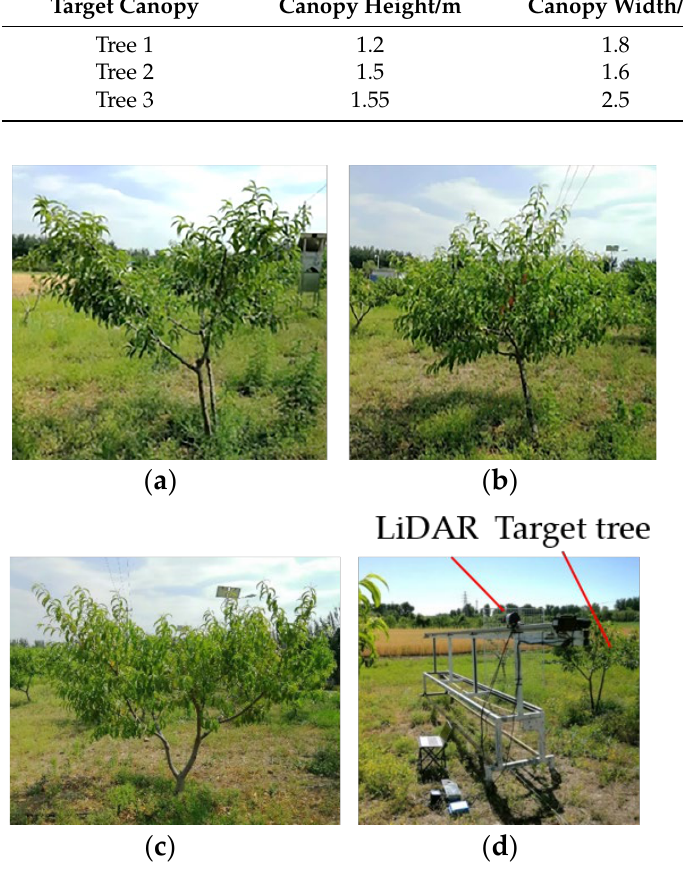
Figure 6. Orchard experiment: ( a ) Tree 1; ( b ) Tree 2; ( c ) Tree 3; ( d ) canopy detection. During point cloud data collection, LiDAR was detected at a distance of 2.5 m from the centreline of the tree row with a constant scanning frequency and angular resolution, and the mobile platform was always parallel to the tree row. The target-oriented variable of the spraying speed in orchards is usually 1 m/s [30]. The slower the LiDAR moving speed is, the greater the density of the acquired point cloud, and the more detailed the detected canopy contour. In this experiment, the LiDAR was controlled to collect canopy point clouds at speeds of 0.6 m/s, 0.8 m/s, and 1 m/s. The process was repeated four times for each detection speed. Before point cloud collection, the mesh lines were removed to prevent the mesh lines on the outer edge of the canopy from affecting the canopy. The effect of depth probing left only the two mesh lines at the centre and outer edge of the tree row at the bottom of the canopy as markers for point cloud